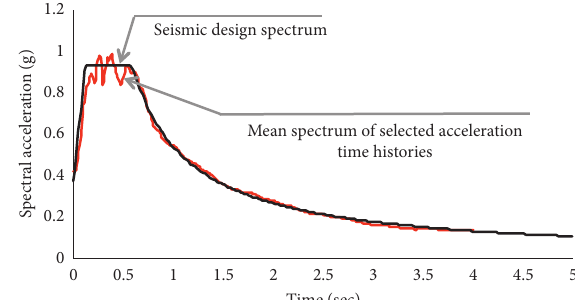
Figure 19: Comparison of mean spectrum of matched acceleration records to the seismic design spectrum.